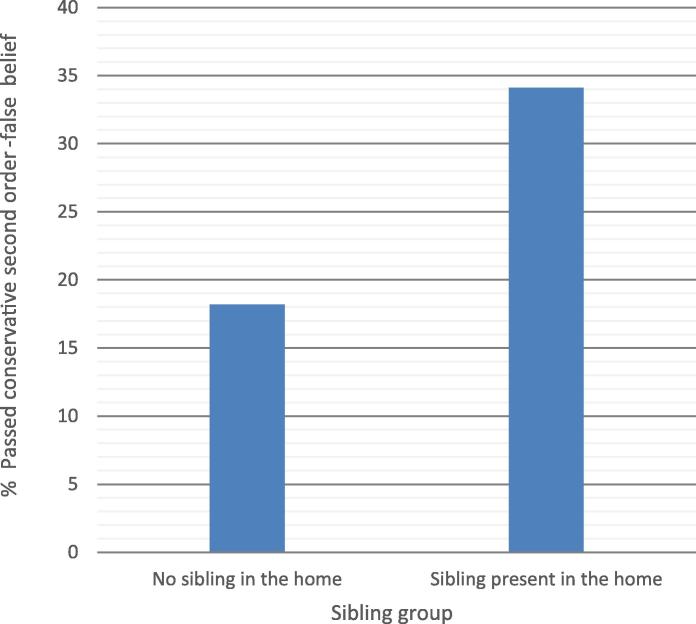
Percentages of children who passed second-order false belief with full comprehension according to whether the firstborn had a sibling present in the home.